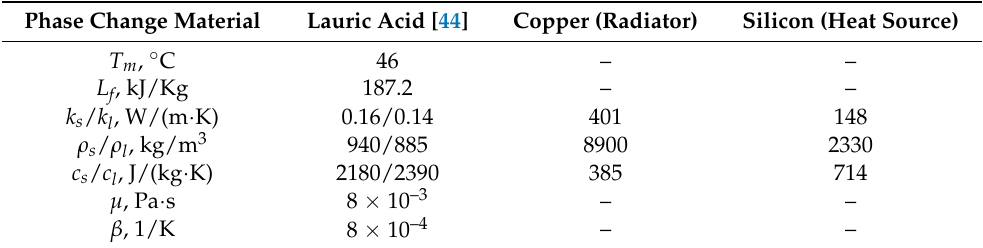
Table 1. Properties of